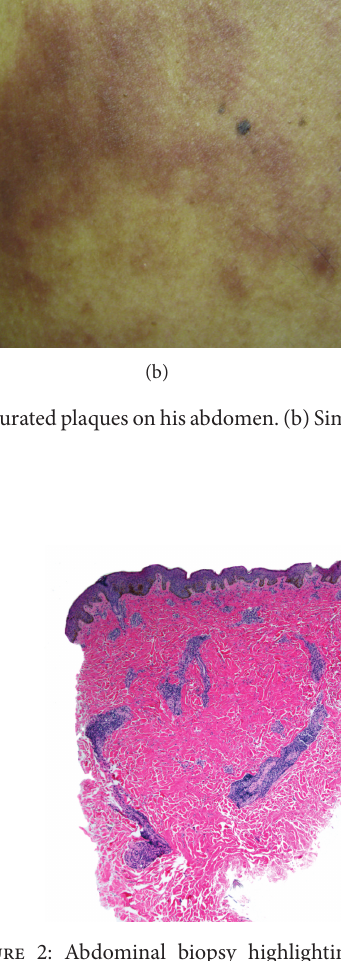
Figure 2: Abdominal biopsy highlighting dermal plasmacytes, which were evident in biopsies of the patient’s abdomen, flank, and neck (hematoxylin & eosin stain; original magnification: × 40).